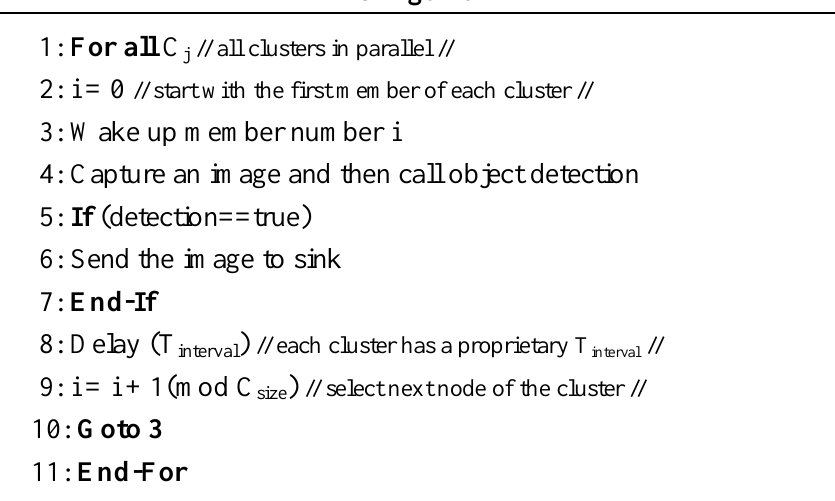
Table 2. Cluster-based Cooperative Scheduling for Object Detection. The